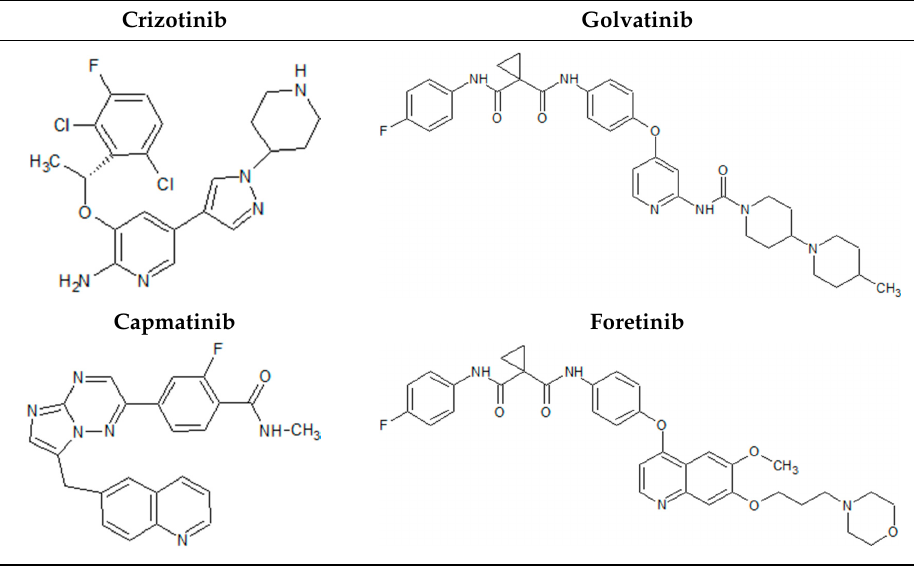
Table 1. Inhibitors of the HGF/c-Met axis under investigation in HNSCC.